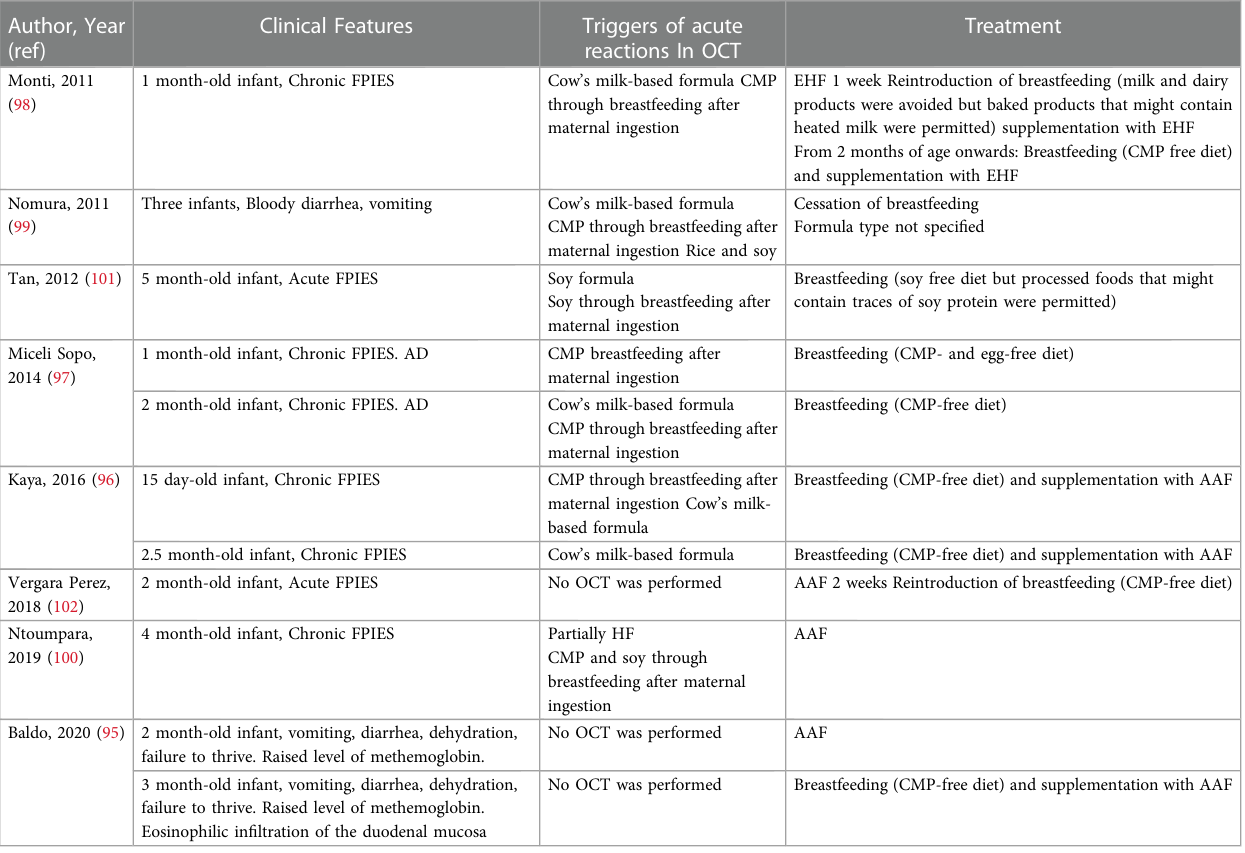
TABLE 1 Severe food protein-induced enterocolitis syndrome (FPIES) in infants exclusively